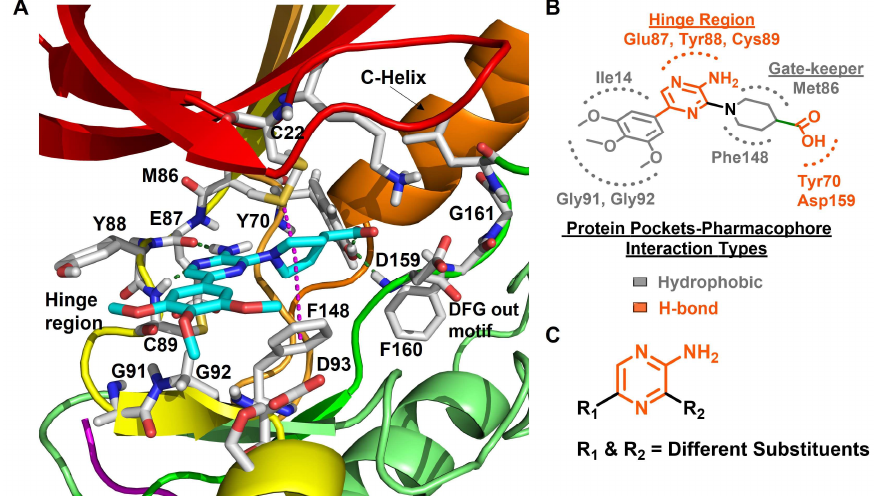
Figure 8. ( A ) Crystal structure of AP-1 and Nek2 complex. Trimethoxyphenyl group occupies the space between Ile and glycine-rich loop (G91 and G92). The piperidine ring is sandwiched between Phe148 and Met86, whereas the carboxyl establishes a H-bonding network between Tyr70 and Asp159. Aminopyrazine also establishes H-bonding interactions with the hinge region. All polar interactions are depicted by green dotted lines, whereas non-polar interactions are presented as purple dashed lines. (PDB code: 2xkf). ( B ) Schematic representation of AP-1 binding to Nek2, in which protein-ligand interactions have been designated using different color schemes. ( C ) Generic structure of 2-aminopyrazine analogs.